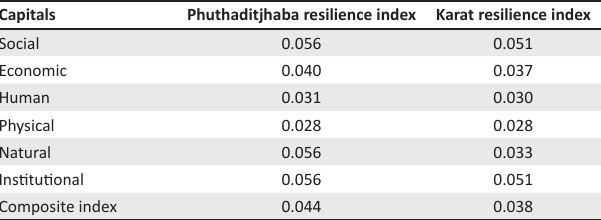
TABLE 3: Resilience risk index based on calculations of capitals. Capitals